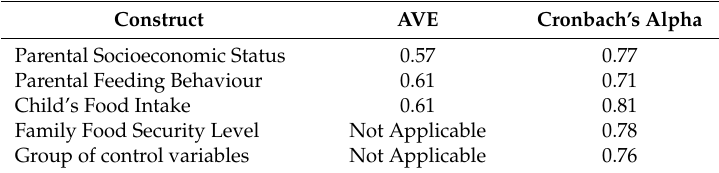
Table 6. Results of average variance extracted (AVE) and Cronbach’s alpha.